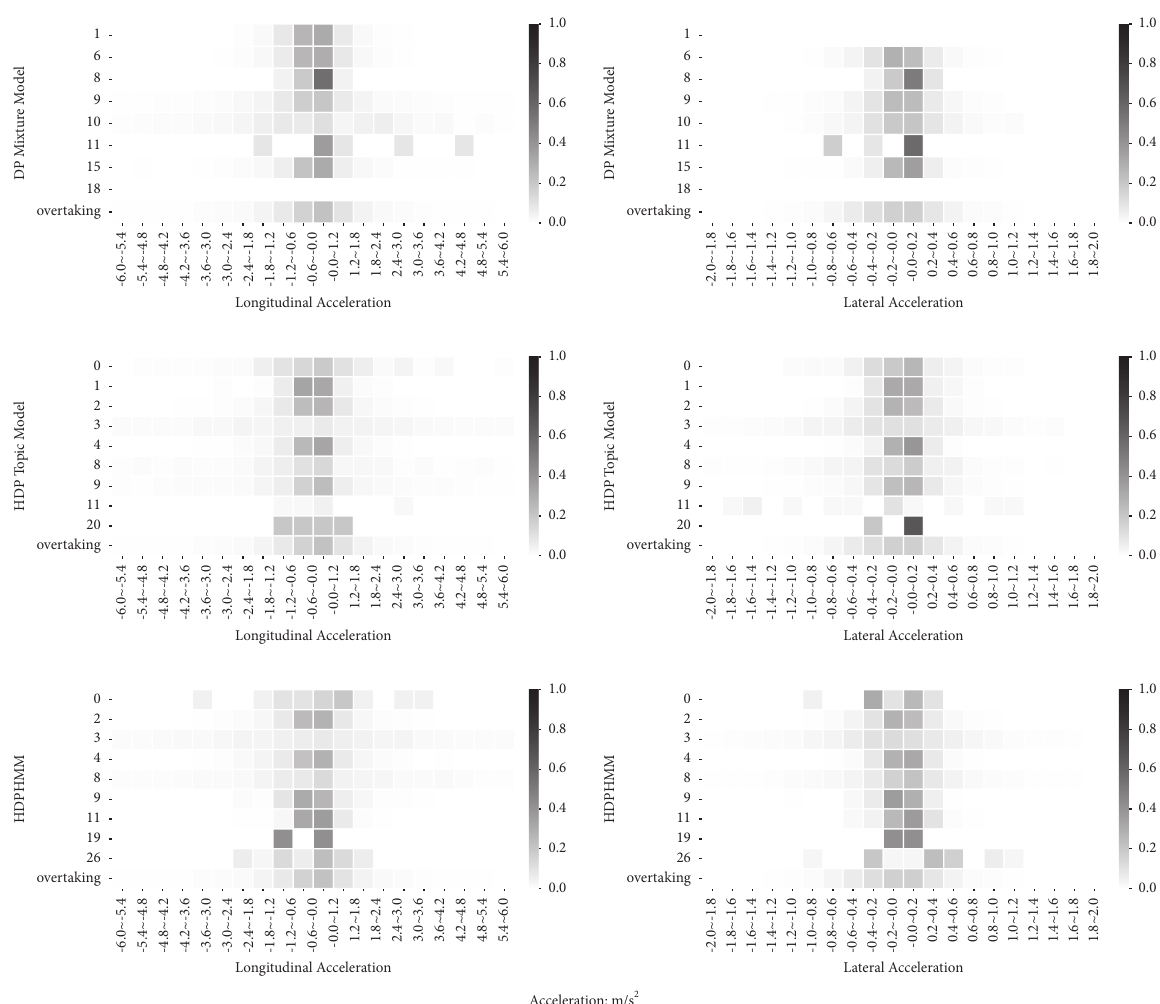
Figure 12: Acceleration’s heat map of different clusters in different